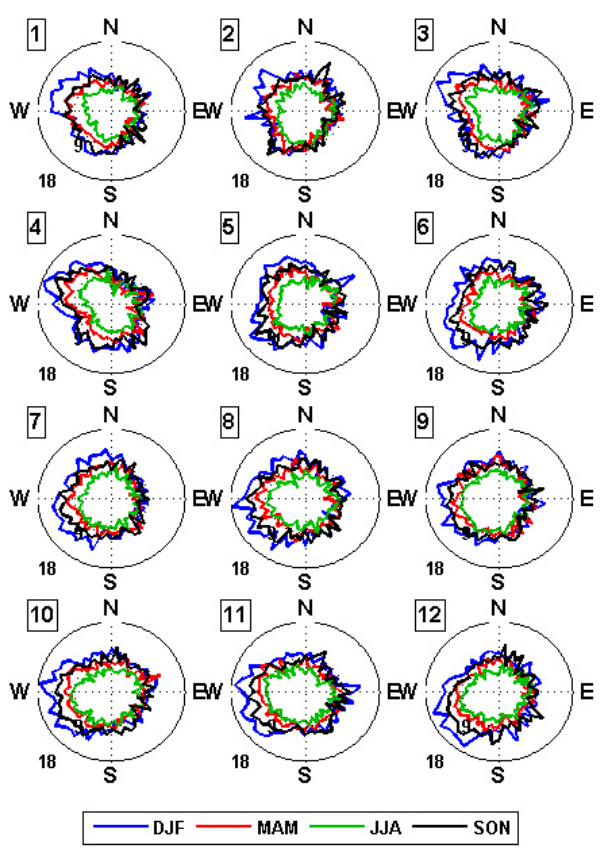
Figure 9. Average wind speed at 850hPa corresponding to the wind directions shown in Fig. 8 at 12 radar stations during different sea- sons based on the daily data from ERA-Interim